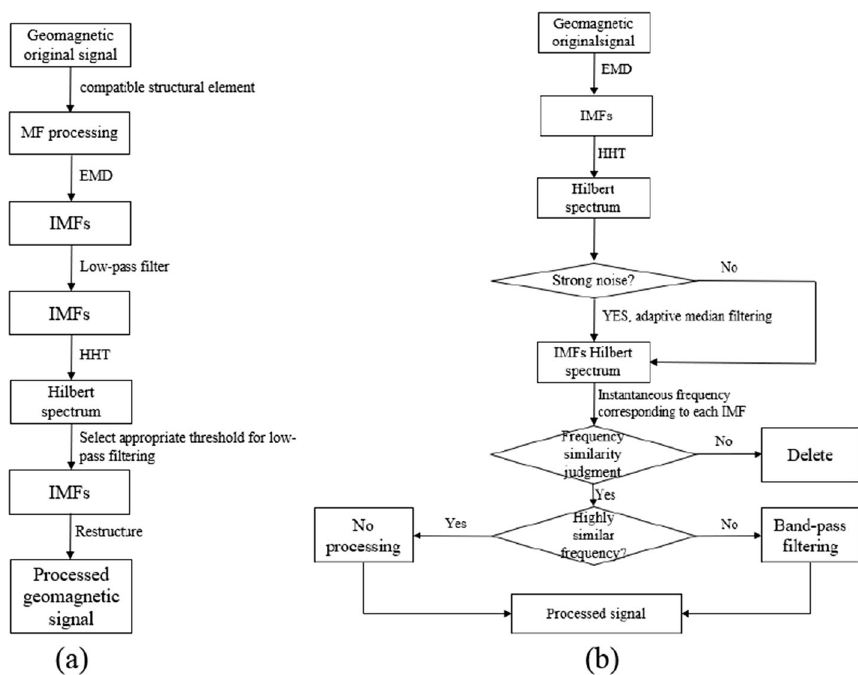
Fig. 10 a is Li Ji’s algorithm and b is Zhou’s algorithm